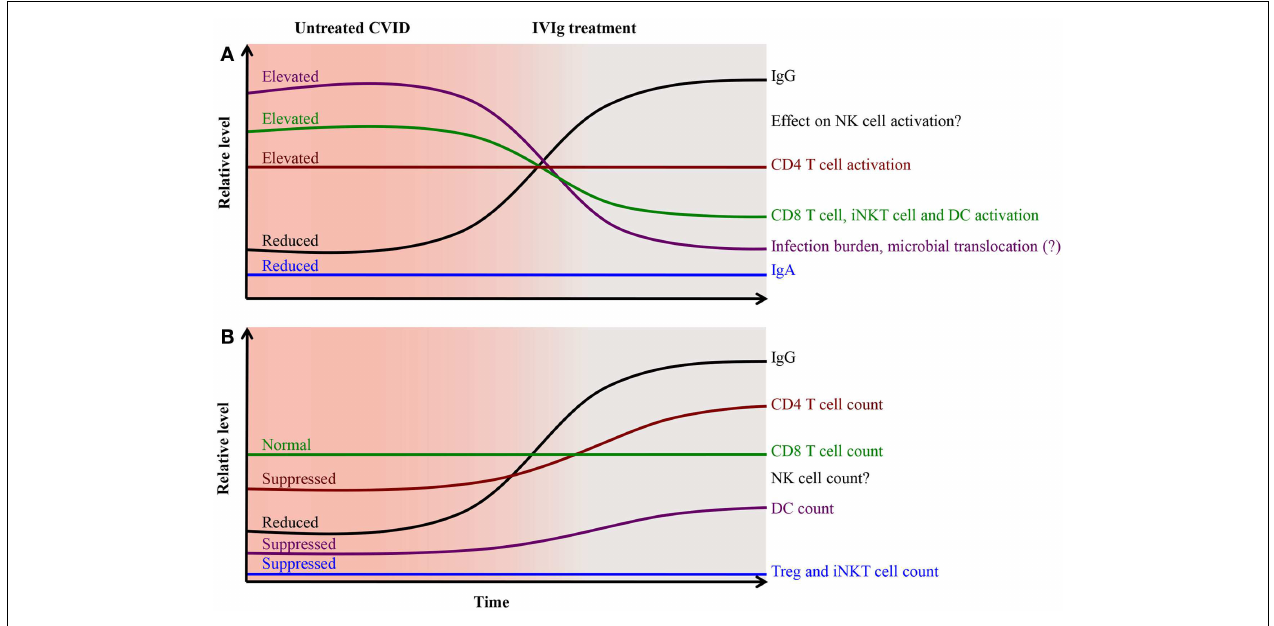
immune system.This together with triggering of the FcR-mediated inhibitory effects on antigen presenting cells leads to reduced activation of CD8T cells, iNKT cells, and DCs (A) and improvement in CD4T cell counts and DC count (B)